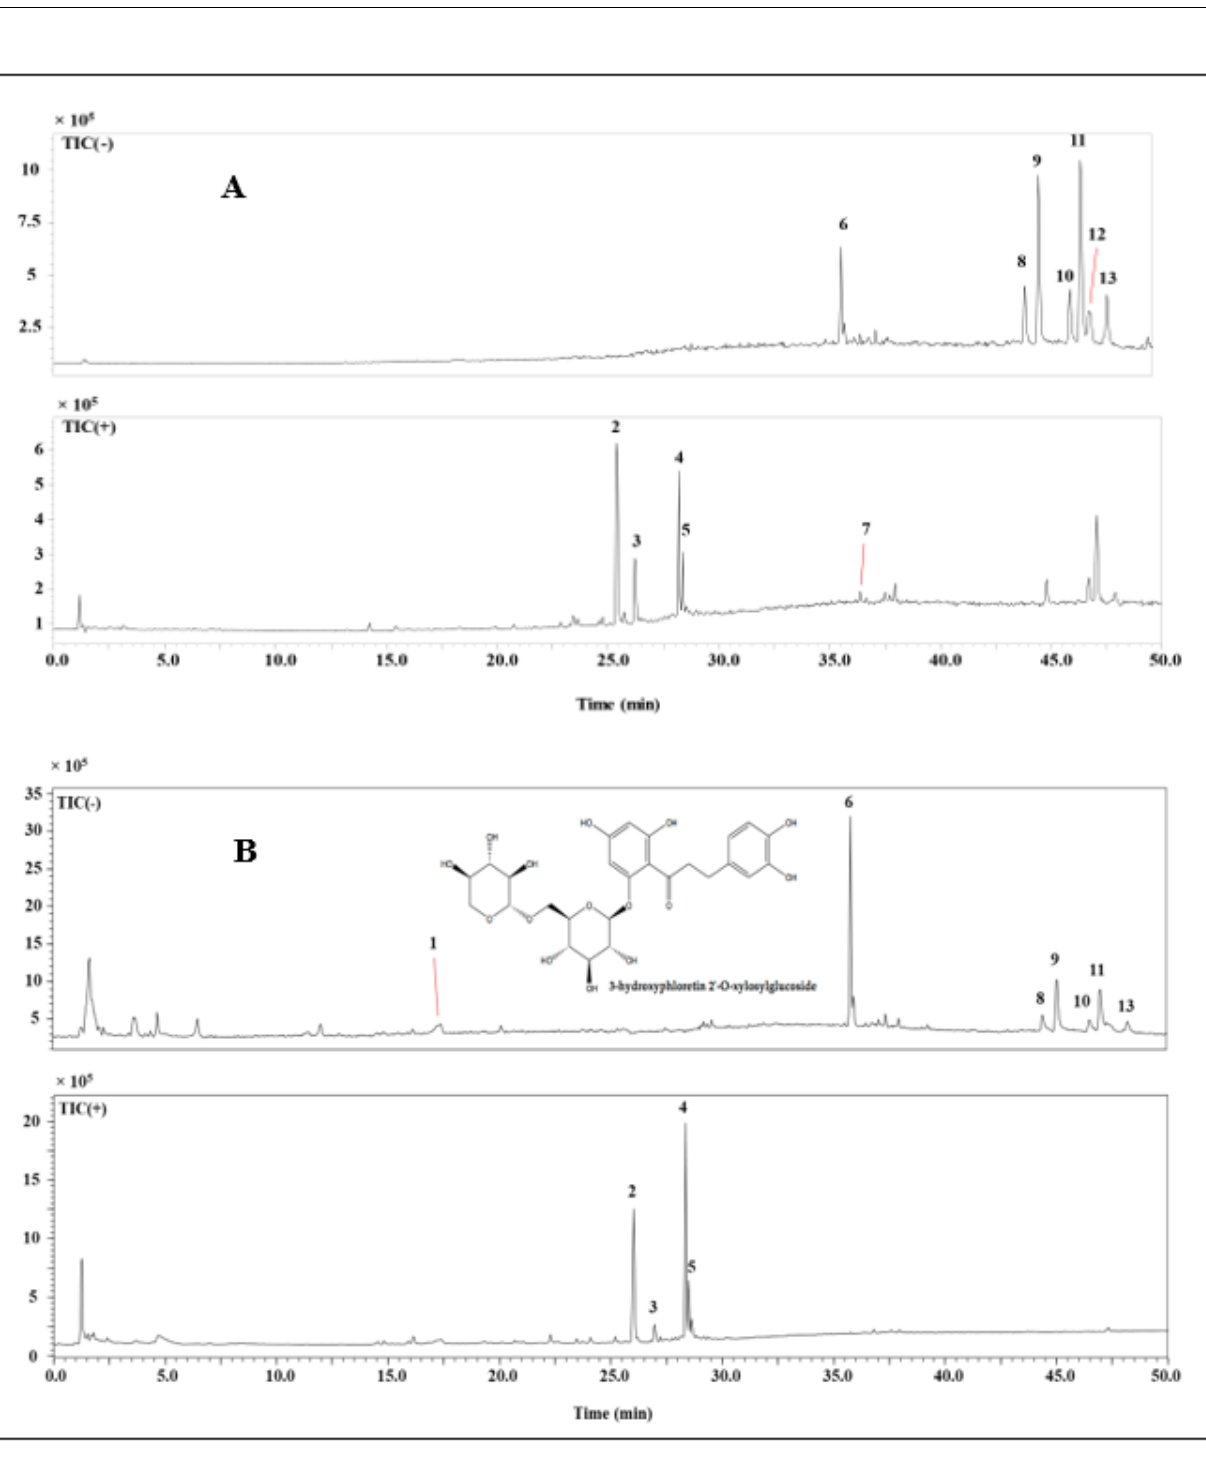
Figure 3. Chromatogram of mass spectrometry in positive and negative modes of bioactive compounds in non-alcoholic ( A ) and alcoholic beers ( B ).